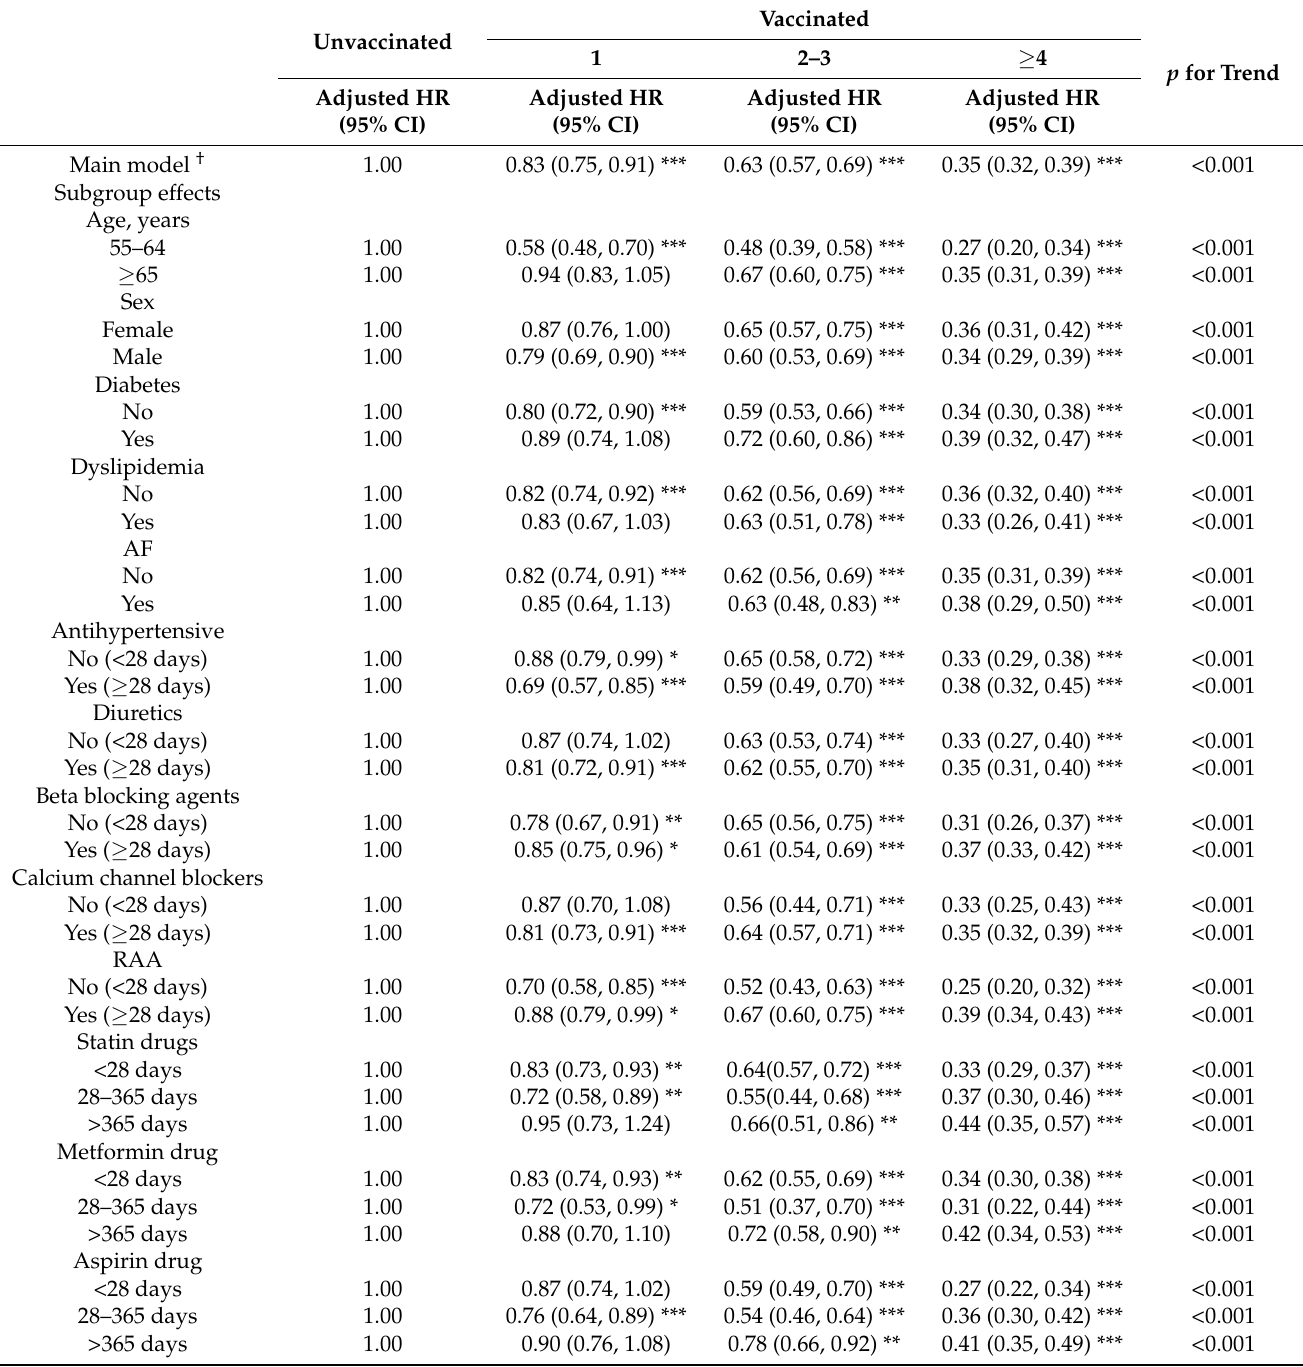
Table 4. Sensitivity Analysis of Adjusted HRs of Vaccination in the Risk Reduction of All Strokes in the Non-Influenza Season.